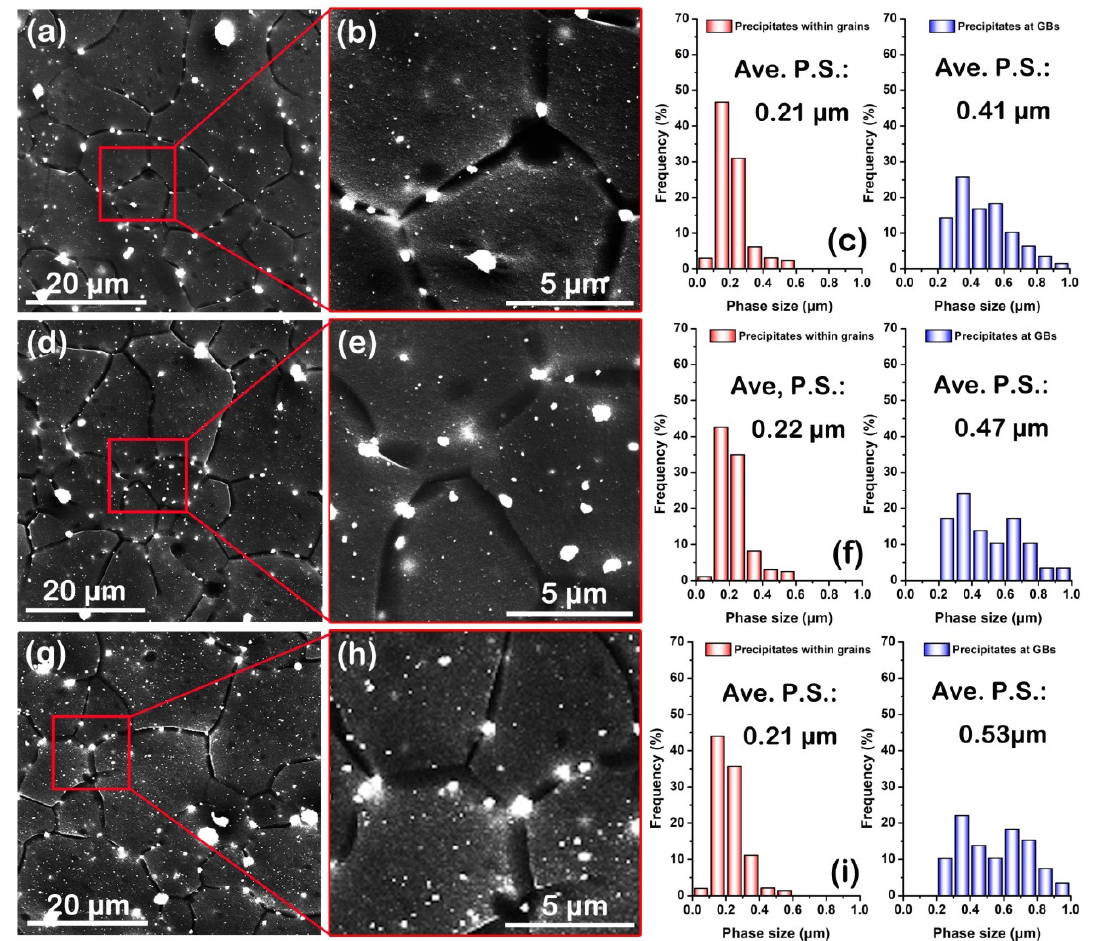
Figure 9. SEM images and phase size distribution maps of precipitates (including within grains and at grain boundaries) in as-extruded AZB313 alloy after high-temperature annealing for ( a – c ) 0.5, ( d – f ) 3, and ( g – i ) 5 h.